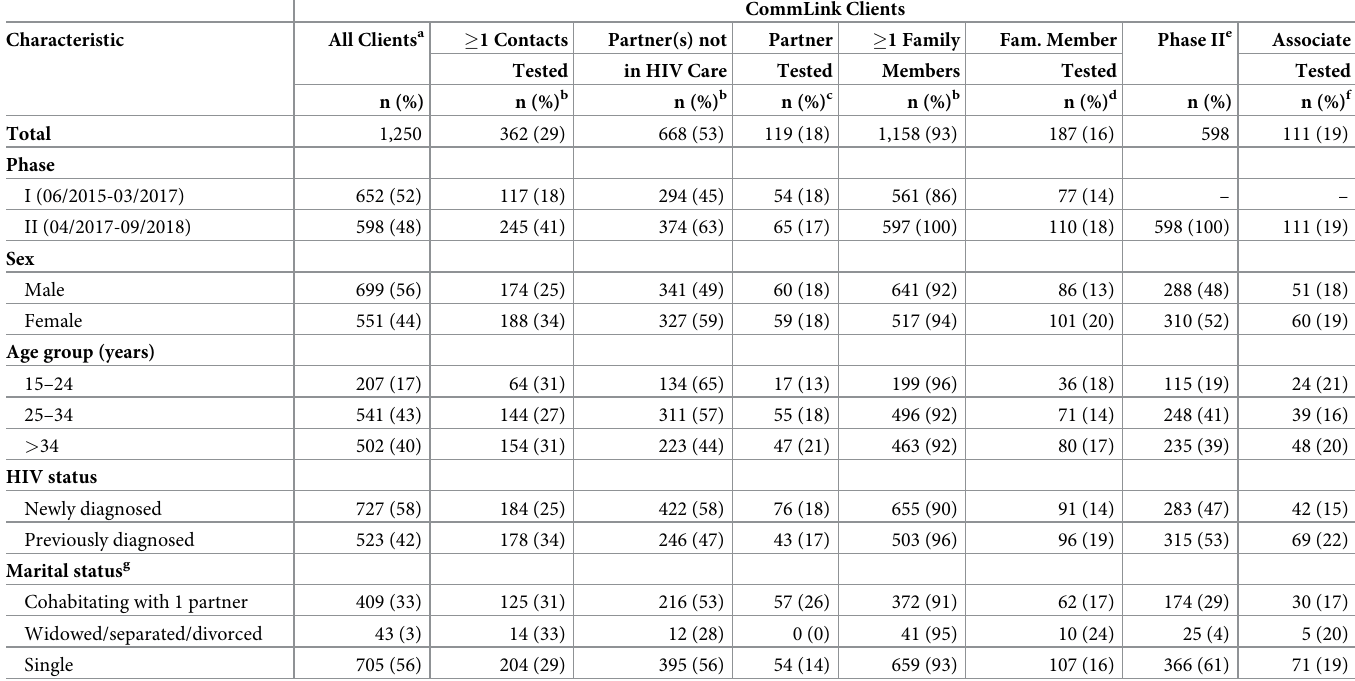
Table 1. HIV testing of � 1 sexual partners, family members, and high-risk associates (contacts) of CommLink clients, by program phase and client characteristics, Eswatini, June 2015 –September